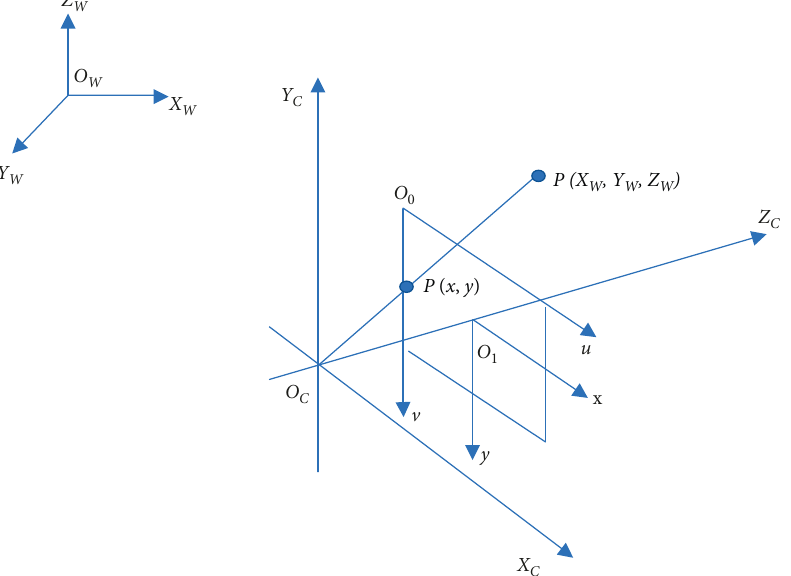
Figure 3: Correspondence between the four coordinate systems.